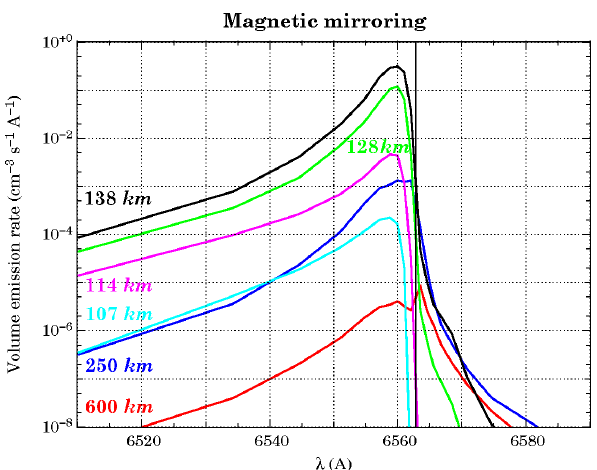
Fig. 5. H α emission rate Doppler profile computed for collisional angular redistributions applied successively below 1keV (solid line) and below 10keV (dashed line). The Rutherford formula is used. One can see the red wing extend significantly in amplitude when angular redistributions below a higher threshold are